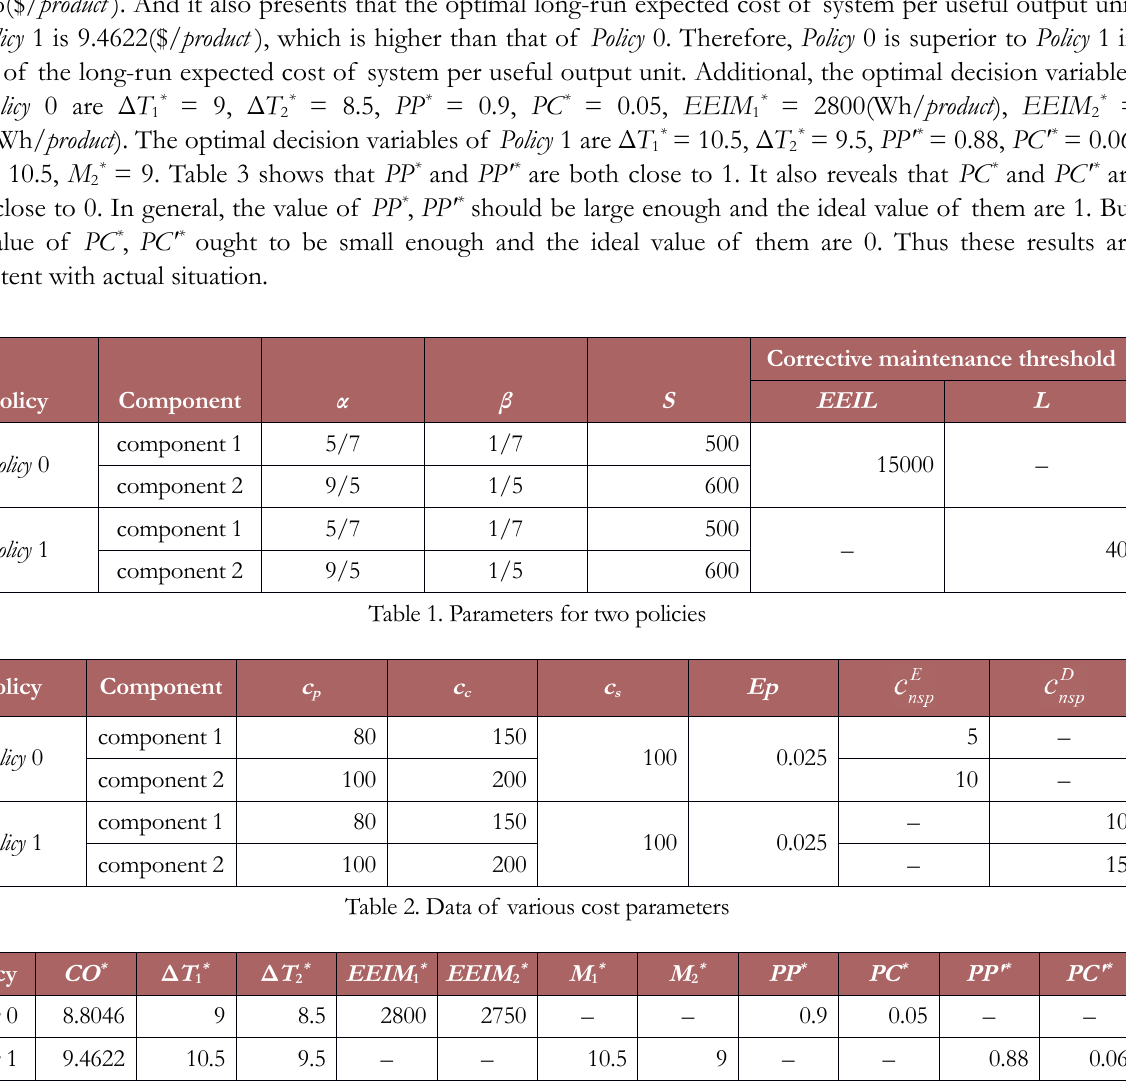
Table 3. CO * and optimal decision variables for two